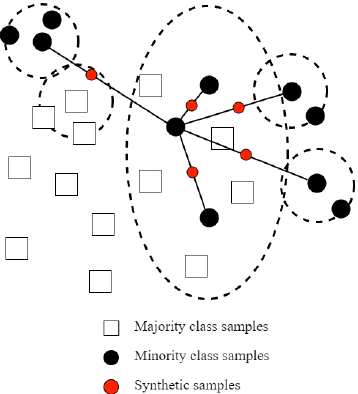
Figure 5. Visualization of SMOTE technique